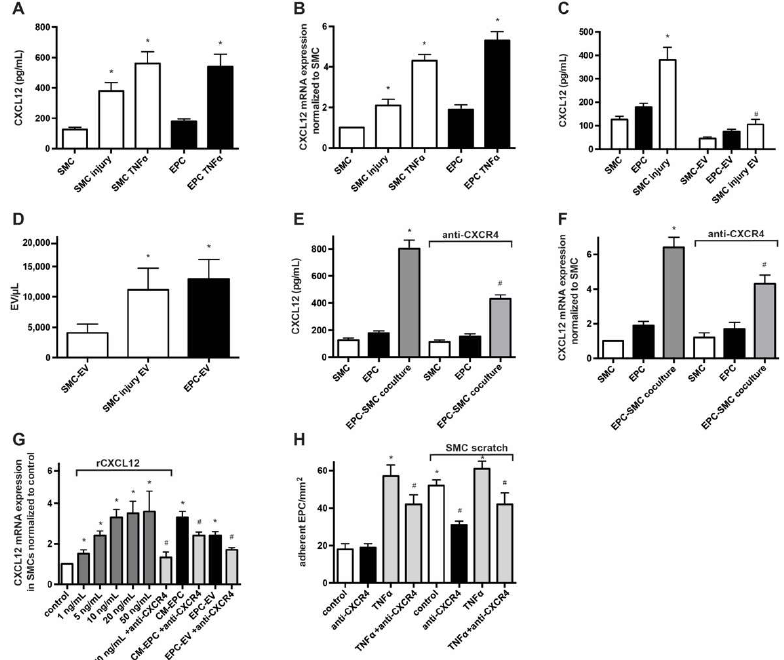
Figure 1. Expression and release of CXCL12 by SMCs and EPCs. ( A ) Analysis of CXLC12 release using ELISA. Cell supernatants from monocultured SMCs and EPCs, treated as indicated, were collected 24 h after cultivation. * p < 0.05 vs. untreated cells; n = 6. ( B ) Real-time RT-PCR analysis of CXCL12 expression SMCs and EPCs treated as indicated. Results were normalized to CXCL12 expression in SMCs. * p < 0.05 vs. untreated cells; n = 5. ( C ) Detection of CXCL12 in MVs derived from monocultured SMCs and EPCs. Isolated MVs were lysed in RIPA buffer and CXCL12 levels were determined using ELISA. * p < 0.05 vs. non-injured SMCs, # p < 0.05 vs. SMC-MV; n = 5. ( D ) Enumeration of MVs in the supernatant of EPCs, non-injured SMCs and injured SMCs using flow cytometry with calibrated microbeads. * p < 0.05 vs. non-injured SMCs; n = 4. ( E ) Evaluation of the effect of EPC-SMC co-cultivation and engagement of CXCR4 on the release of CXCL12. Supernatants from monocultured SMCs, monocultured EPCs and EPCs co-cultured with SMCs, each in the presence or absence of a blocking CXCR4 Ab, were analyzed for CXCL12 concentration using ELISA. * p < 0.05 vs. SMCs, # p < 0.05 vs. EPC-SMC co-culture in the absence of anti-CXCR4; n = 5. ( F ) Real-time RT-PCR analysis of CXCL12 expression to test the impact of EPC-SMC co- cultivation and involvement of CXCR4. CXCL12 transcripts were determined in SMCs, EPCs and EPC-SMC co-cultures in the presence or absence of a blocking CXCR4 Ab. * p < 0.05 vs. SMCs, # p < 0.05 vs. EPC-SMC co-culture in the absence of anti-CXCR4; n = 5. ( G ) Real-time RT-PCR analysis of CXCL12 expression in SMCs treated with various doses of rCXCL12, CM-EPC or EPC-MV in the presence or absence of an anti-CXCR4 Ab. * p < 0.05 vs. untreated SMCs (control), # p < 0.05 vs. respective treatment in the absence of anti-CXCR4; n = 5. ( H ) Adhesion of EPCs to SMCs under flow conditions in vitro. EPCs pretreated with/without an anti-CXCR4 Ab were perfused in a parallel flow chamber and the number of cells EPCs adherent to the SMC monolayer was determined and expressed as adherent cells per 1 mm². For some experiments, the SMC monolayer was wounded by a linear scratch before perfusion of EPCs. * p < 0.05 vs. untreated and non-scratched SMCs (control), # p < 0.05 vs. respective treatment in the absence of anti-CXCR4; n = 4 to 6.